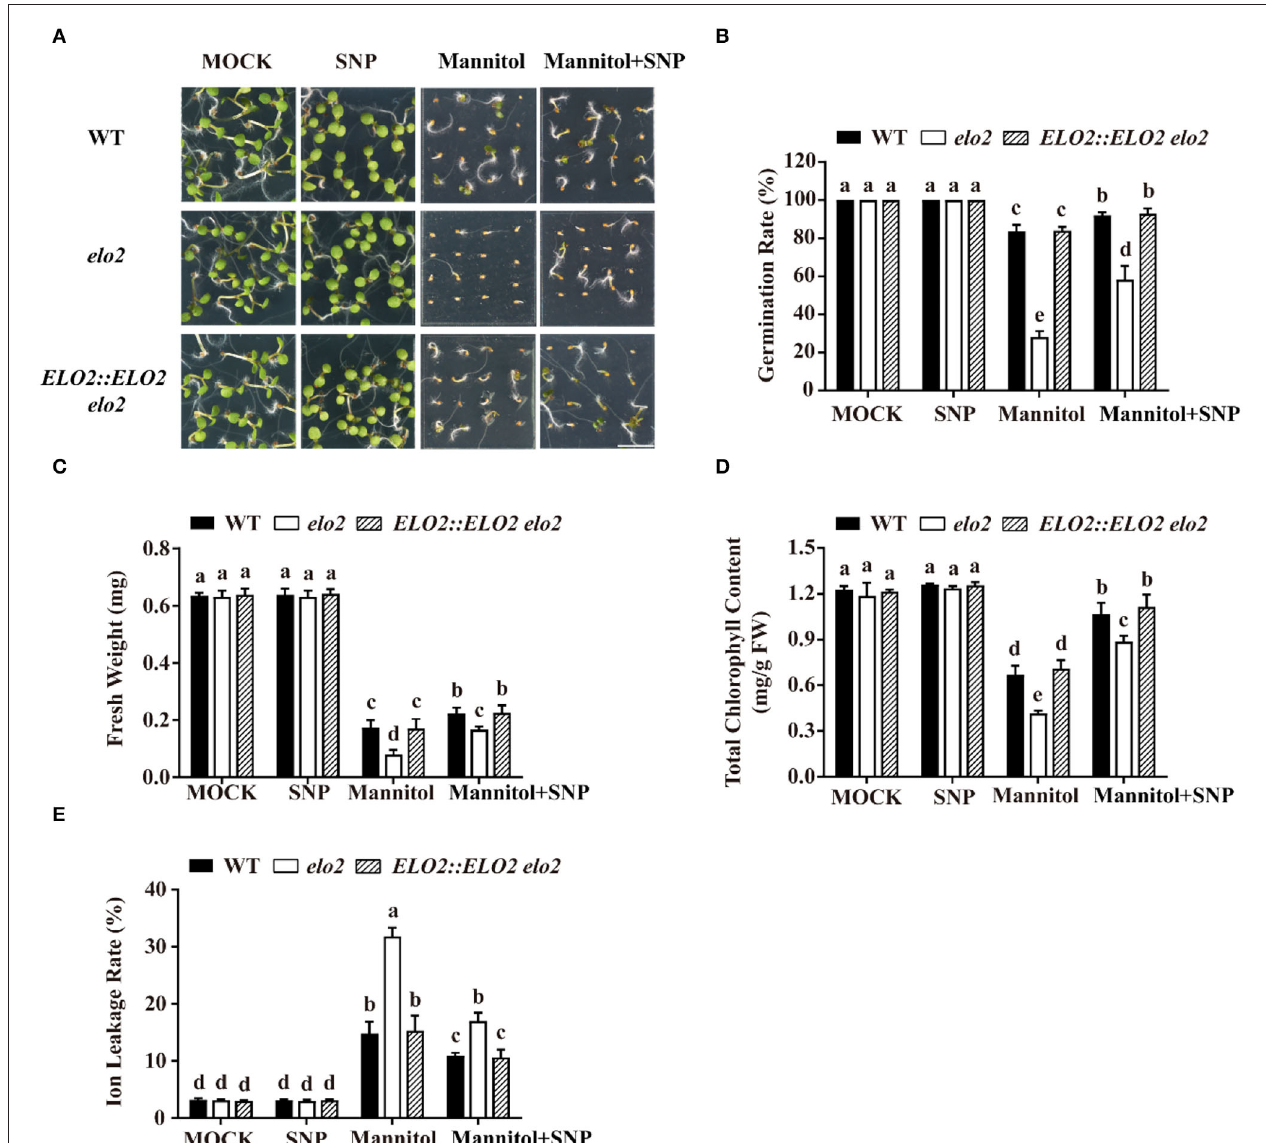
FIGURE 3 | SNP alleviates the sensitivity of elo2 to osmotic stress. (A–C) Phenotypes (A) , germination rate (B) , and fresh weight (C) of WT, elo2 , and ELO2::ELO2 elo2 plants under the treatment of 5 µ M SNP, 250mM mannitol, and 250mM mannitol plus 5 µ M SNP for 5 days. (D,E) Total chlorophyll content (D) and ion leakage rate (E) of 5-day-old WT, elo2 , and ELO2::ELO2 elo2 seedlings treated with or without 5 µ M SNP, 250mM mannitol, and 250mM mannitol plus 5 µ M SNP for 12h. FW: fresh weight. Scale bars = 0.5cm. Data shown are means ± SD of three independent biological replicates. Different letters indicate significantly different values ( P < 0.05 by Tukey’s